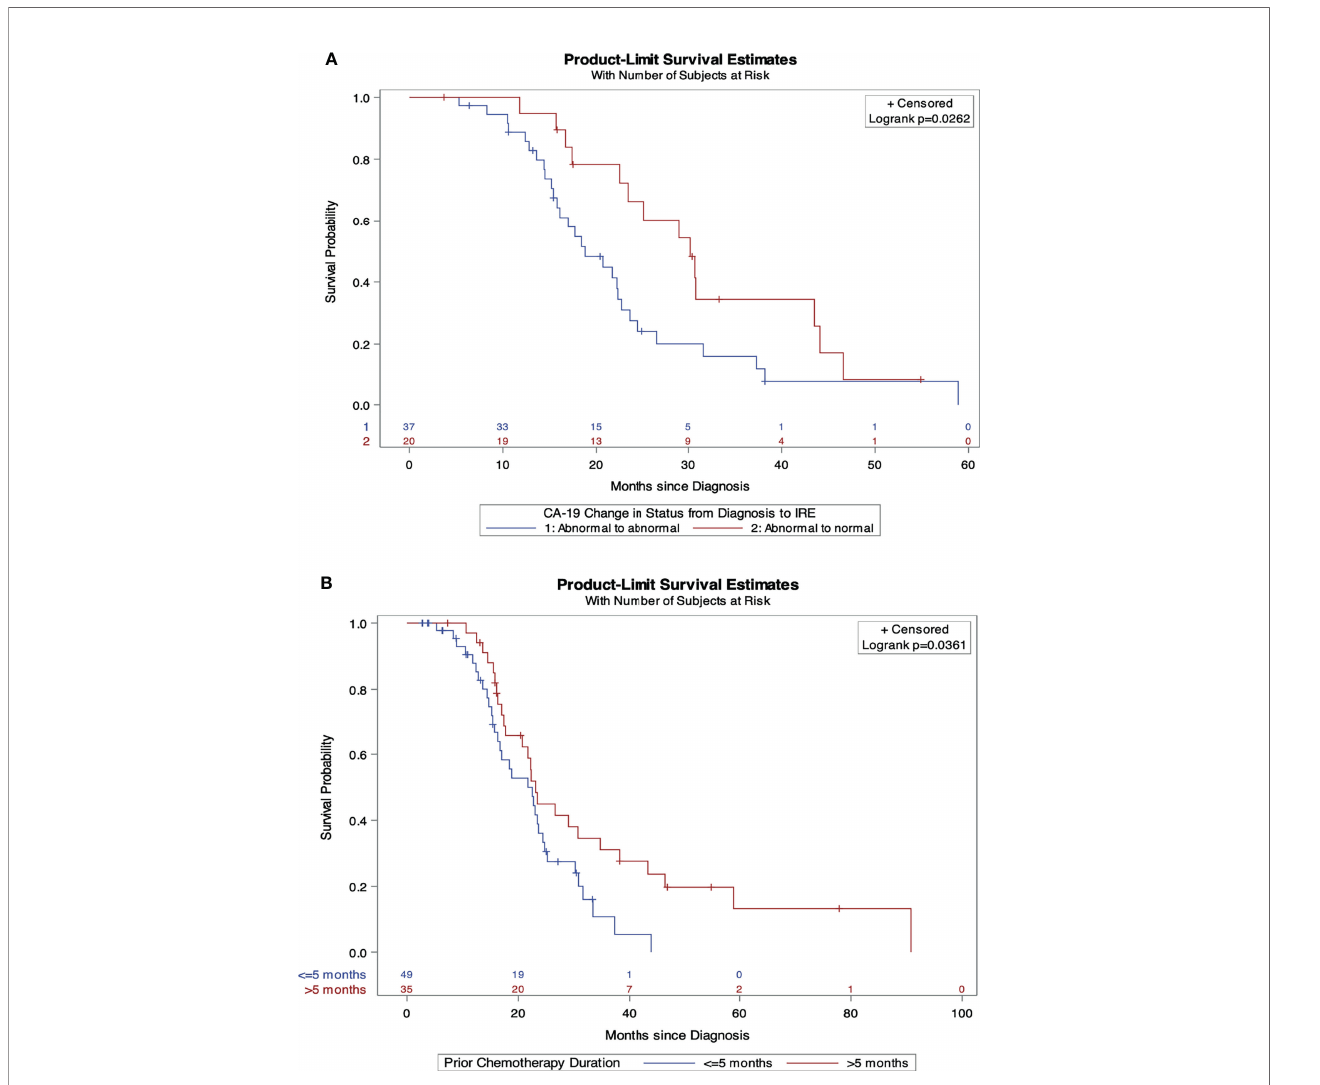
FIGURE 1 | Independent predictors of overall survival from diagnosis. (A) Overall survival comparison by change in CA19-9 status from diagnosis to IRE. (B) Overall survival comparison by induction chemotherapy